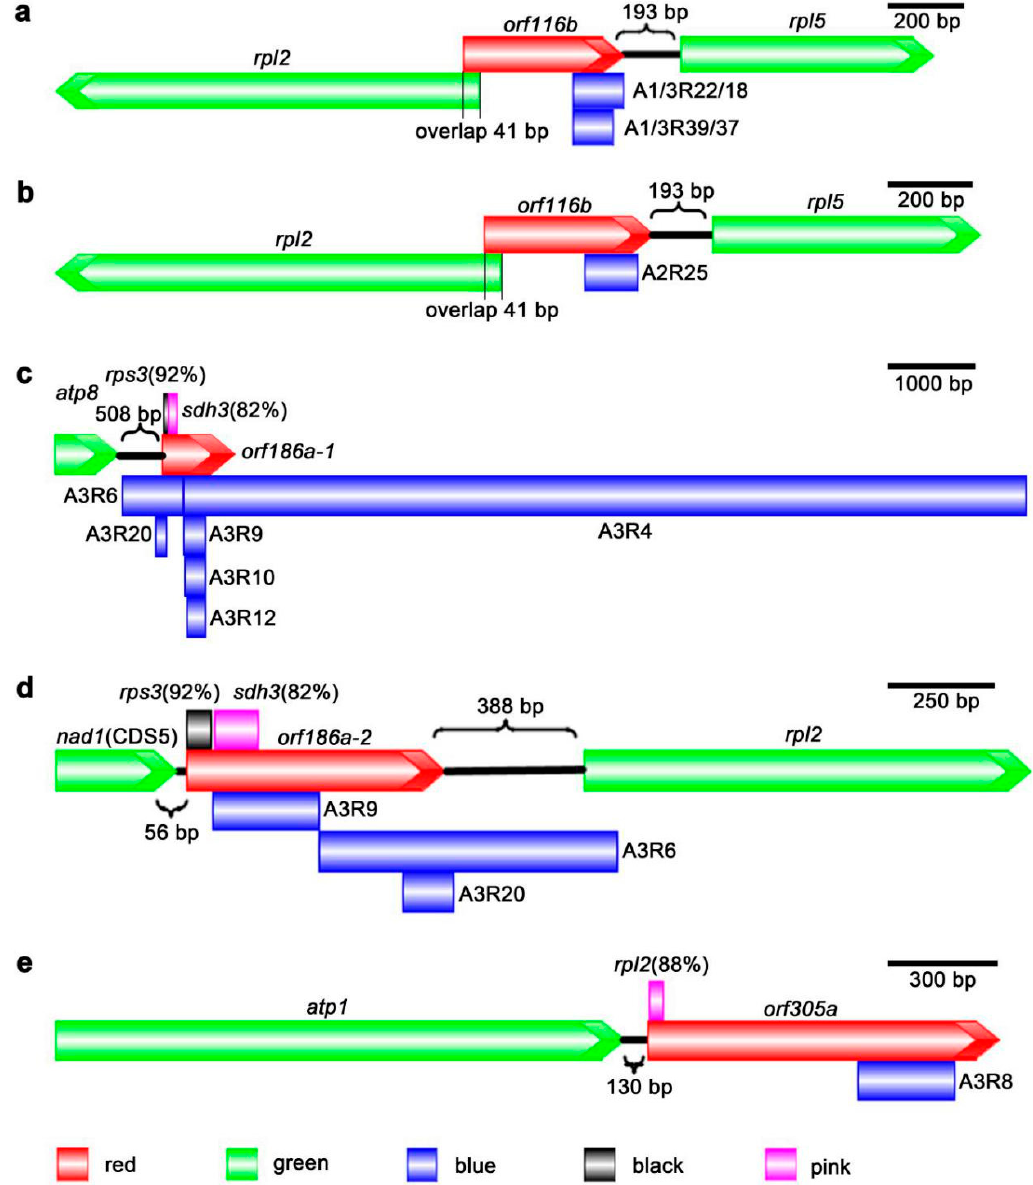
Figure 5. The structures of unique ORFs in the mt genomes of the CMS lines. Note: ( a ), the structure of orf116b unique to J4A-1 and J4A-3; ( b ), the structure of orf116b unique to J4A-2; ( c ), the structure of orf186a-1 ; ( d ), the structure of orf186a-2 ; ( e ), the structure of orf305a.